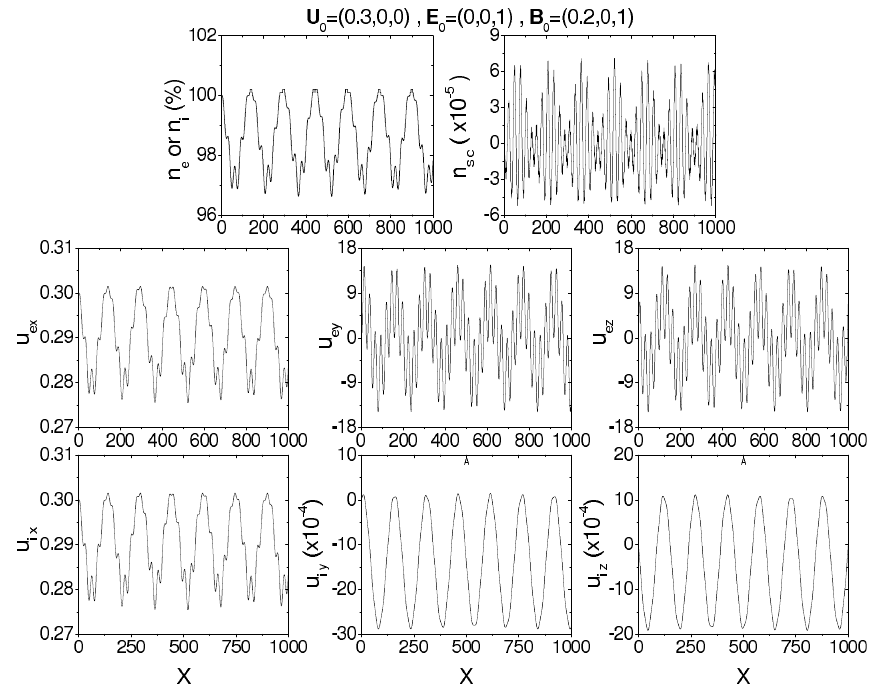
Fig. 10. Typical LH solitary structures. Shown in panels of the figure are solitons’ density ( n e or n i ; top left), space-charge density ( n sc ; top right), three components of electron velocity ( u ex , u ey , u ez ; middle row), and that of ion velocity ( u ix , u iy , u iz ; bottom row). Initial conditions and input parameters as follows: (cid:8) u xx0 ,u y0 ,u z0 (cid:9) = { 0 . 3 , 0 , 0 } , (cid:8) E x0 ,E y0 ,E z0 (cid:9) = { 0 , 0 , 1 } , (cid:8) B x0 ,B y0 ,B z0 (cid:9) = { 0 . 2 , 0 , 1 } ; M =1,